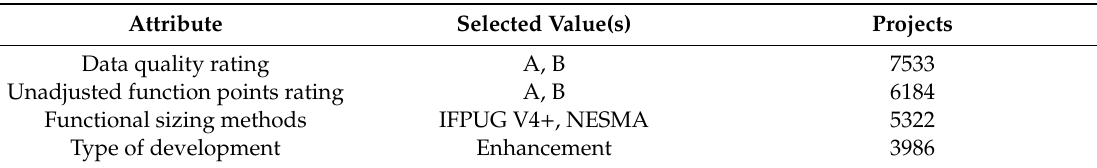
Table 1. Criteria for selecting software enhancement projects from the International Software Benchmarking Standards Group (ISBSG) data set. Attribute Selected Value(s) Projects Data quality rating A, B 7533